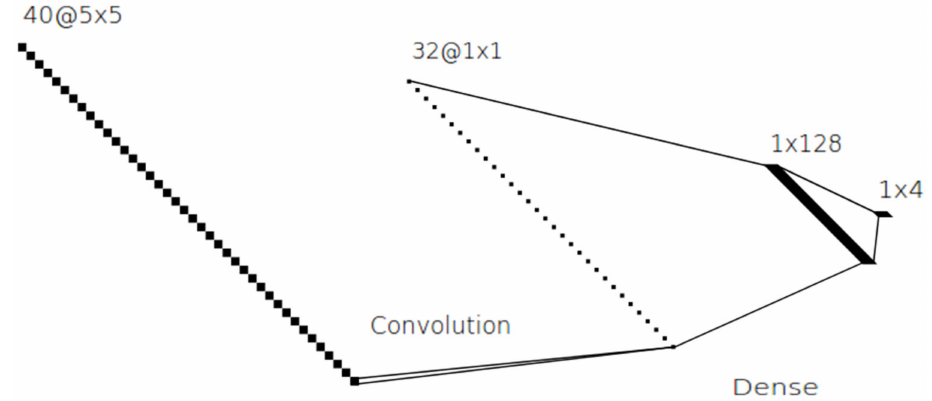
Figure 4. The adopted CNN architecture for the case with input patches of 5 × 5